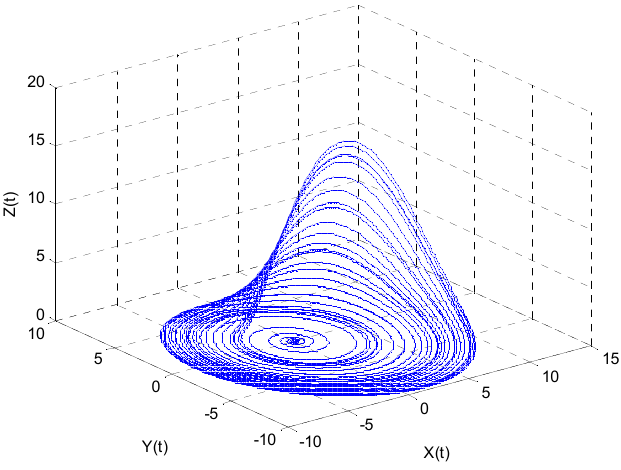
Figure 4. A Rossler chaotic number generator with a = 0.2, b = 0.4, c =